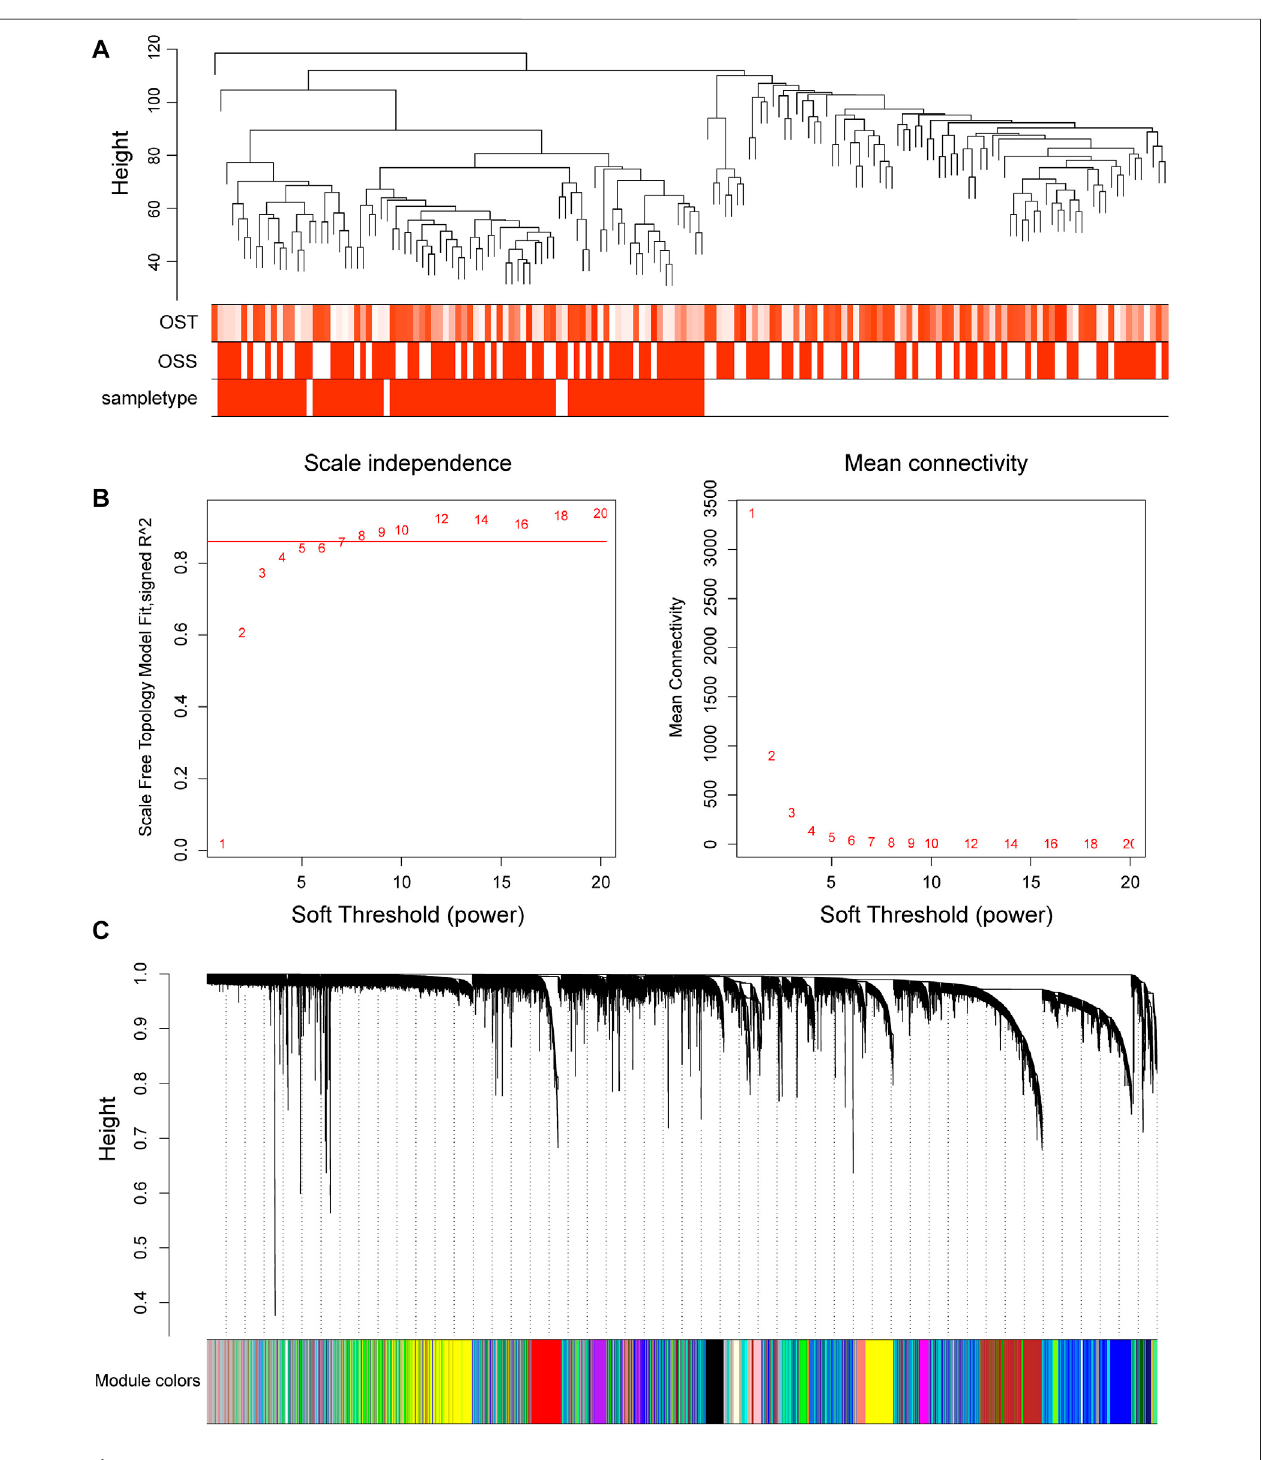
FIGURE 2 | Progress of the weighted gene co-expression network analysis in GSE66229. (A) Cluster dendrogram of 161 samples in GSE66229. (B) Soft thresholds of the best scale-free topological model fi tting index (left) and mean connectivity (right) were determined. The red horizontal line represents R 2 = 0.86. (C) Dendrogram of all genes clustered in GSE66229. Gene clustering into modules is based on a topological overlap matrix. Assigned modules are colored on the bottom with gray denoting unassigned genes.